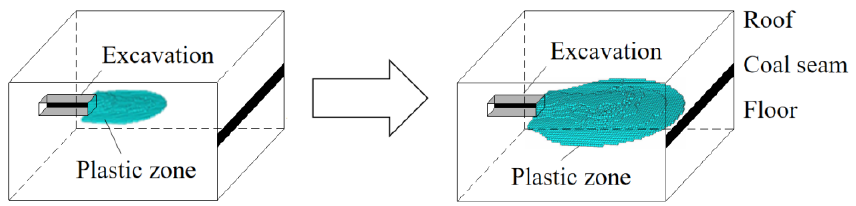
Figure 9. The expansionary evolution of the plastic zone in event Ⅳ .